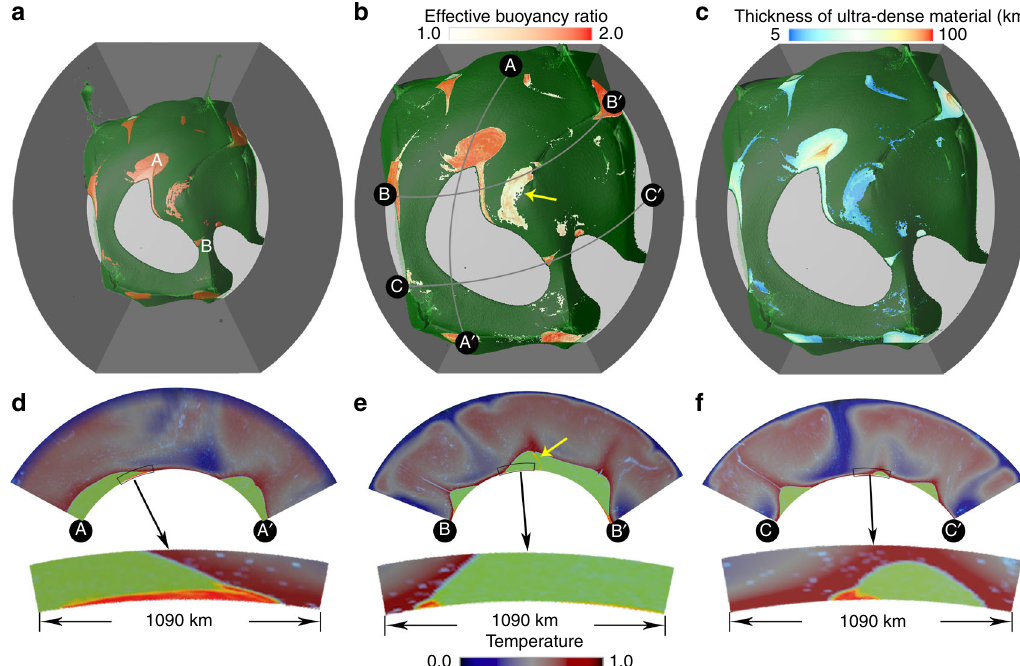
Fig. 3 Morphology and distribution ULVZs caused by compositionally distinct ultradense material. a Distribution of ultradense material ( red isosurface ) beneath large-scale thermochemical piles (partially transparent green isosurface ). The lateral length-scale of accumulations of ultradense material at locations A and B is ~1000 and ~100 km, respectively. The exposed Earth ’ s core in downwelling regions is shown by light gray color . b A zoom-in of panel a along with the locations of 3 cross-sections. The effective buoyancy ratio fi eld at 5 km above CMB show the locations of ultradense material ( white to red color ). The yellow arrow points to the region with relatively low-effective buoyancy ratio ( whitish color ) caused by stirring of ultradense material with pile material. c Same as in b but with the thickness of accumulations of ultradense material shown. d – f Cross-section at locations marked by gray lines in b . The temperature fi eld is shown by dark blue to red color , the thermochemical piles are shown in green color in the lowermost mantle and the ultradense material is shown by orange-red color at the base of piles. The yellow arrow in e points to ultradense material that has been viscously entrained up to the top of the pile along the pile edges, and later sank to the bottom of the pile. Beneath each panel is a zoomed-in region outlined by the black box at the edges of piles. All panels a – f are shown at 227